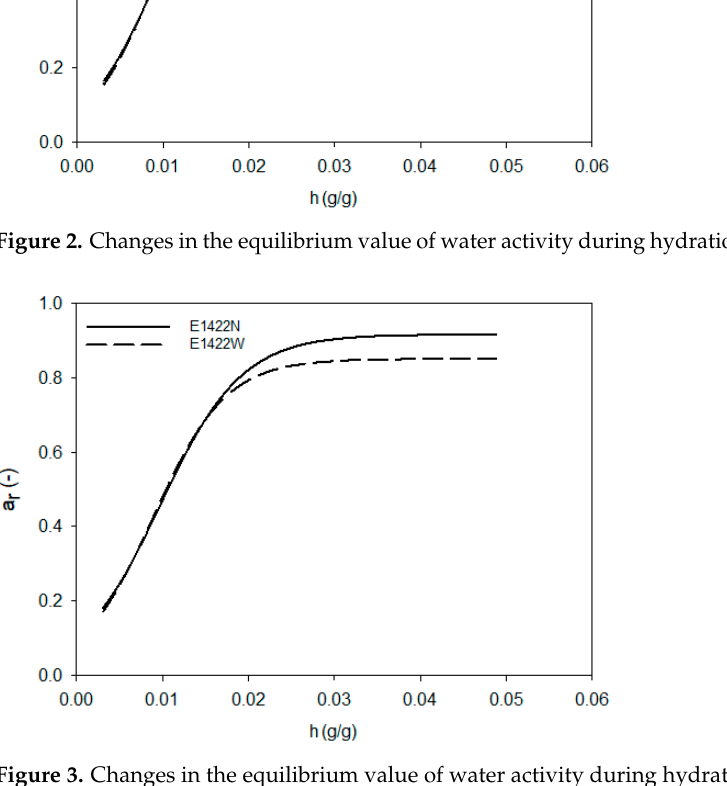
Figure 3. Changes in the equilibrium value of water activity during hydration of acetylated distarch adipate aerogels.